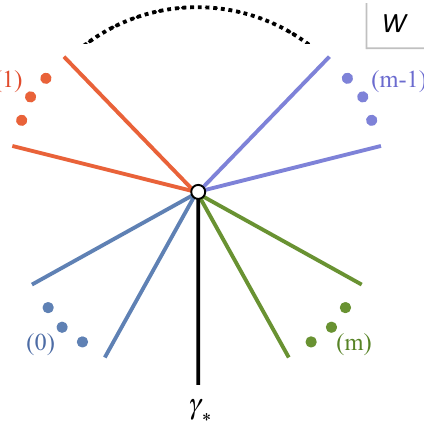
Figure 3. For any reference cycle, the other vanishing paths are ordered on the W -plane according to the degree (indicated in parentheses) of their intersections with it.